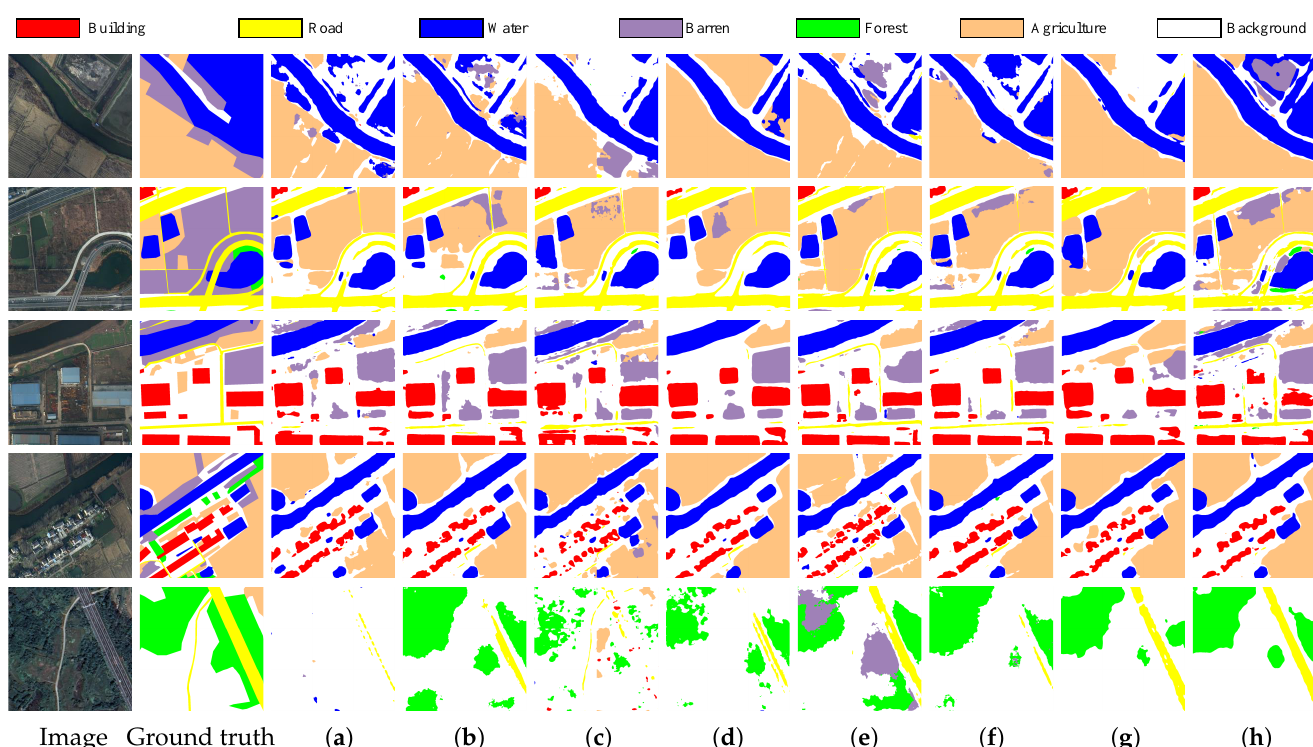
Figure 7. Comparison of visualization results on the LoveDA dataset. ( a ) FCN. ( b ) DeepLabv3+. ( c ) SETR. ( d ) HRNet. ( e ) UNetFormer. ( f ) ST-UNet. ( g ) Baseline. ( h )